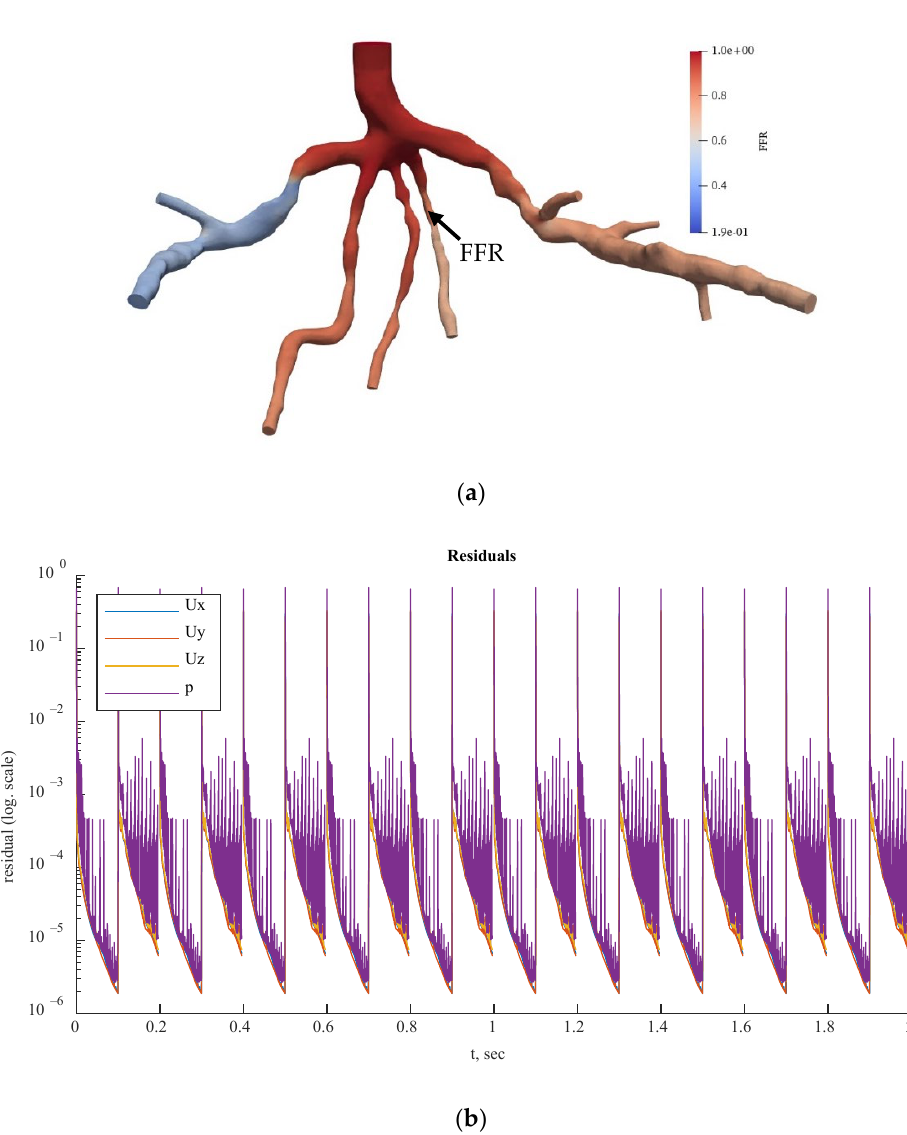
Figure 18. ( a ) FFR distribution with shape of CT209 transient PBA model and ( b ) PBA residual his- tory .